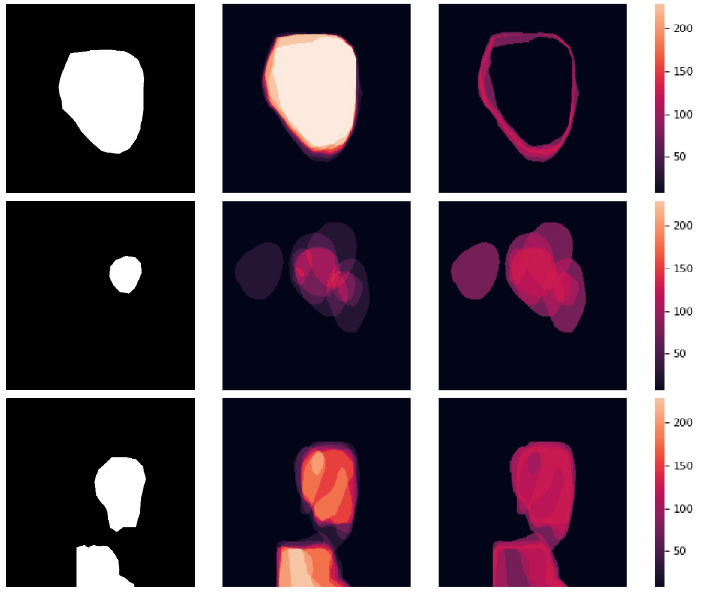
Fig 5. Analyzing diversity of generated data. Real masks are presented on left column. Mean(middle column) and standard deviation (right column) calculated from 10 random masks generated from